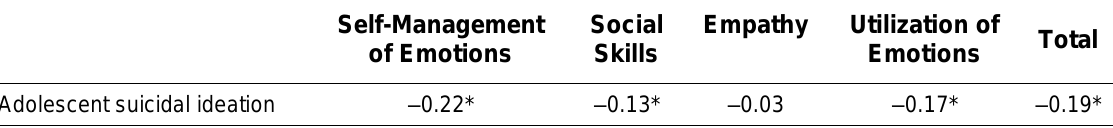
Self-Management Social Empathy Utilization of Total of Emotions Skills Emotions